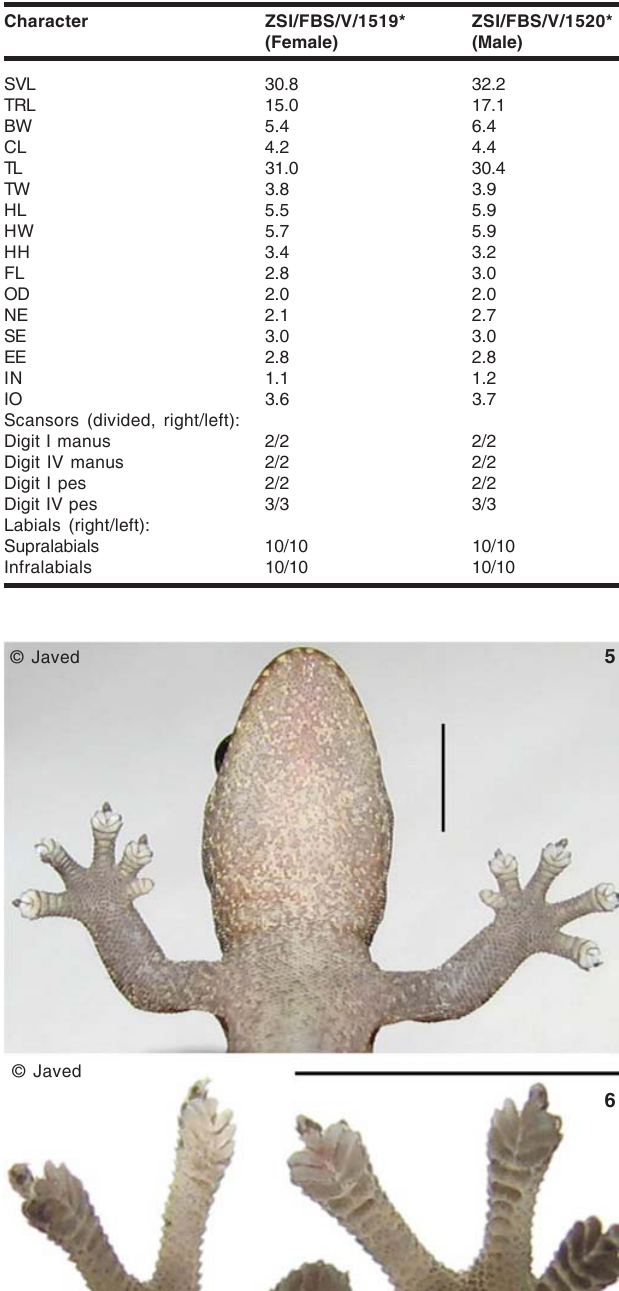
Table 1. Morphometric and meristic data of Hemiphyllodactylus aurantiacus (Beddome, 1870) from Araku Valley, Ananthagiri Hills, Visakhapatnam District, Andhra Pradesh. (All morphometric measurements in mm and abbreviations explained under materials and methods. Asterisks refer to broken